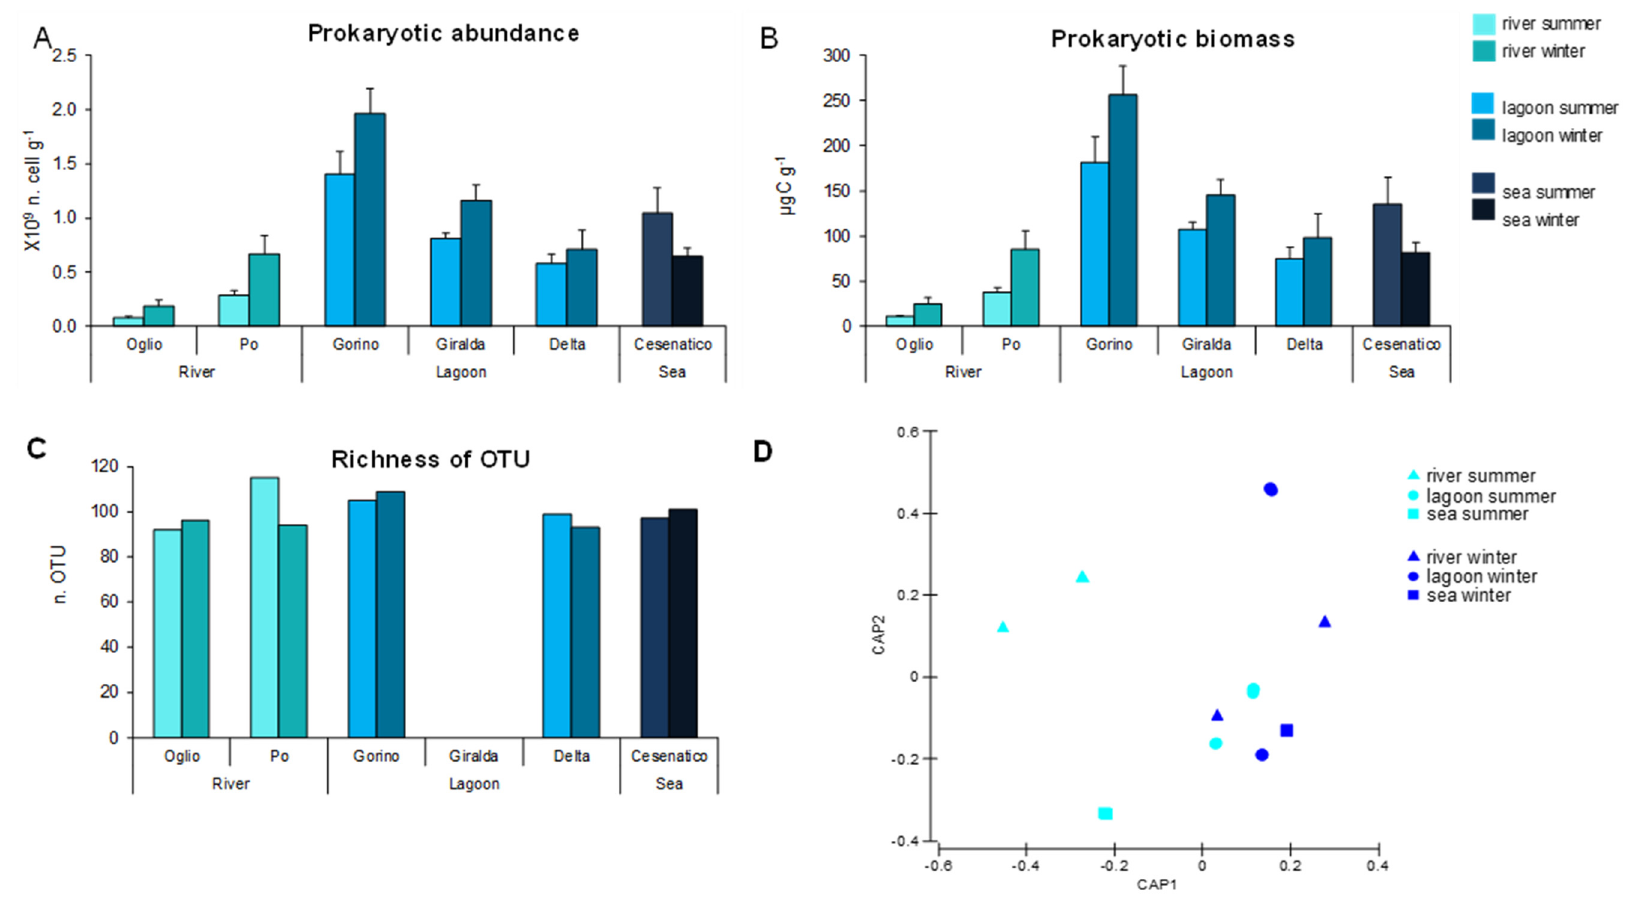
Figure 3. Prokaryotic abundance ( A ), biomass ( B ), richness of Operational Taxonomic Unit (OTU) ( C ), and OTU composition ( D ) in the investigated stations in summer and winter.